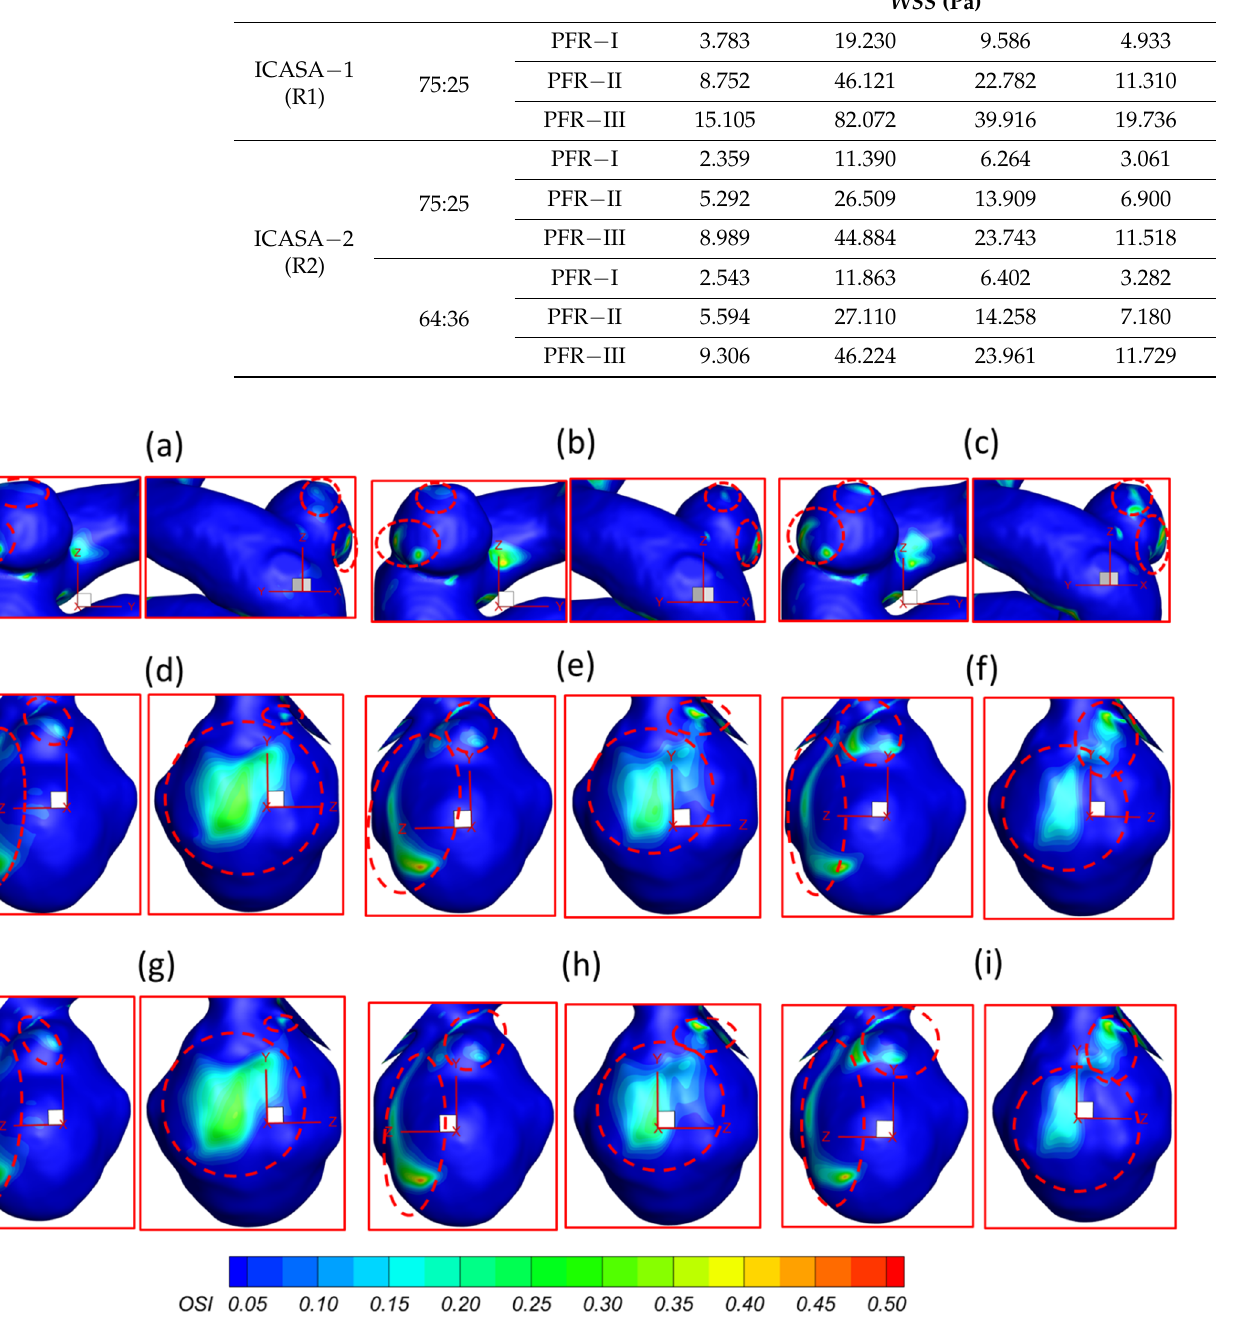
Figure 8. (cid:1841)(cid:1845)(cid:1835) distributions in ICASA−1 and ICASA−2 models under different conditions: ( a ) Figure 8. OSI distributions in ICASA − 1 and ICASA − 2 models under different condi- ICASA−1, q A1 :q A2 = 75:25, and PFR−I, ( b ) ICASA−1, q A1 :q A2 = 75:25, and PFR−II, ( c ) ICASA−1, q A1 :q A2 = 75:25, and PFR−III, ( d ) ICASA−2, q A1 :q A2 = 75:25, and PFR−I, ( e ) ICASA−2, q A1 :q A2 = 75:25, and PFR−II, ( f ) ICASA−2, q A1 :q A2 = 75:25, and PFR−III, ( g ) ICASA−2, q A1 :q A2 = 64:36, and PFR−I, ( h ) ICASA−2, q A1 :q A2 = 64:36, and PFR−II, and ( i ) ICASA−2, q A1 :q A2 = 64:36, and PFR−III.